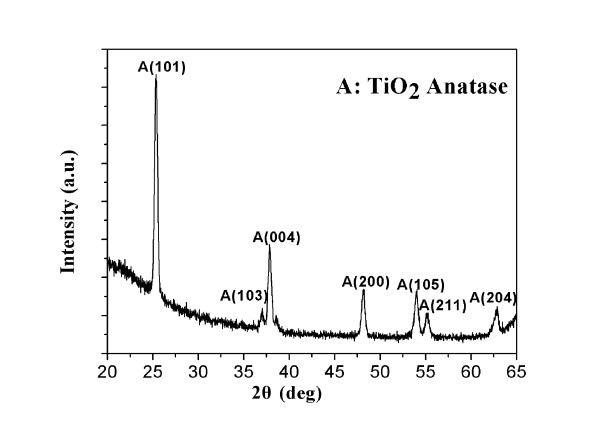
XRD pattern of the TiO2film annealed at 500°C for 2 h in oxygen atmosphere.